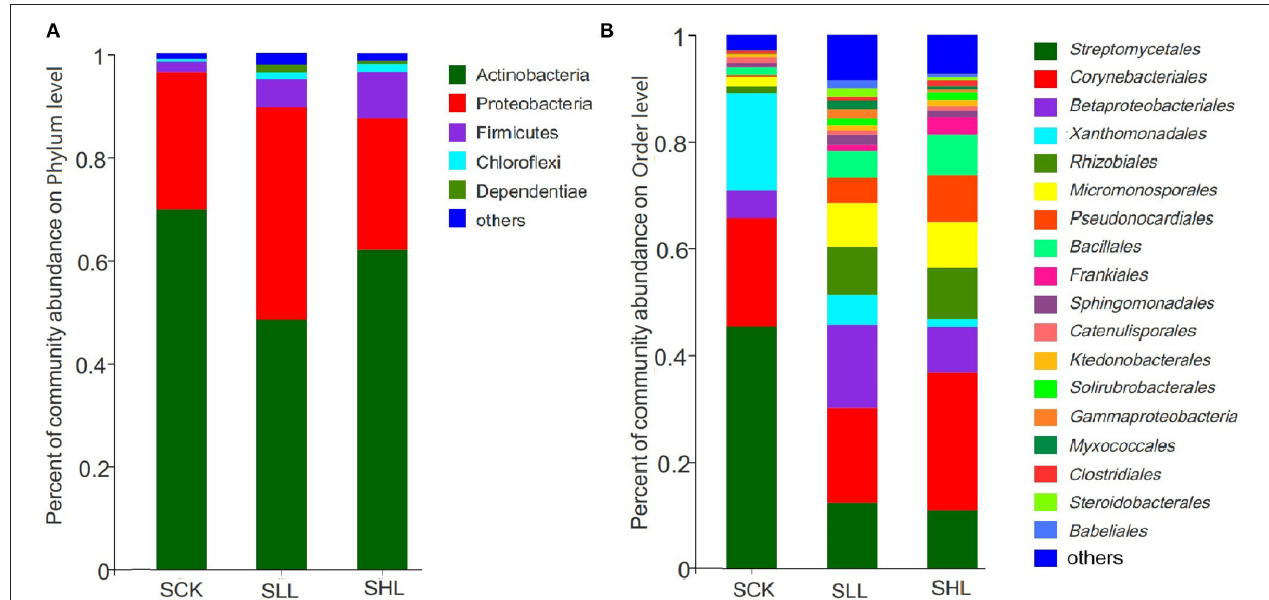
FIGURE 1 | Taxonomic distribution at the phylum (A) and Order (B) level in HLB-infected citrus root samples based on 16S amplicon. SCK, soil without lime treatment; SLL, soil treated with low-level lime; SHL, treated with high-level lime. Taxa with < 1% of reads were combined together as “others”.